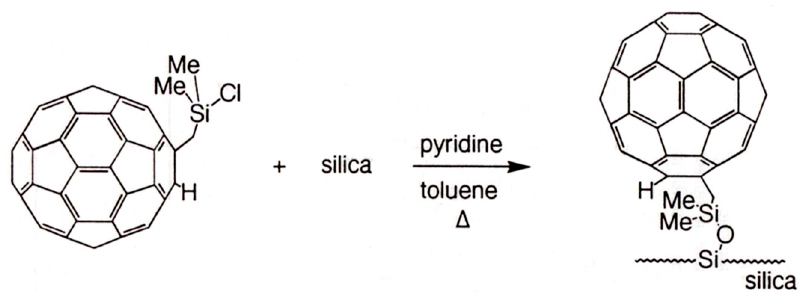
Figure 21. Synthetic scheme for a C 60 bonded silica stationary phase. Reproduced with permission from [87]. Copyright Wiley-VCH, Weinheim, Germany.